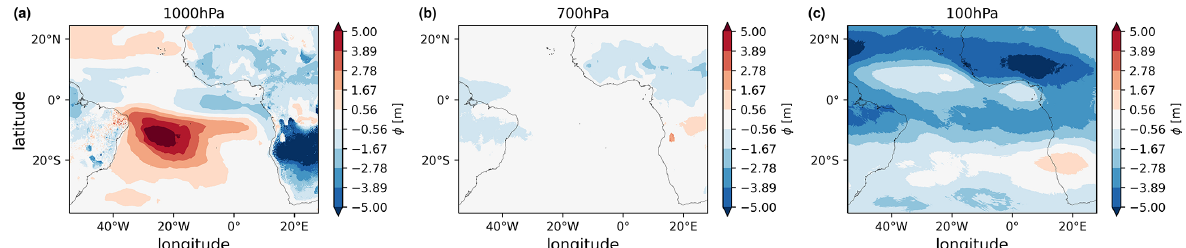
Figure 6. Difference in the geopotential height (m) between PGW boundary conditions derived using EMON and AMON data, respectively, at 1000hPa (a) , 700hPa (b) , and 100hPa (c) at one specific time. In both cases, the pressure adjustment is done with one fixed reference pressure level at 500hPa. Further information about the data used is given in Table